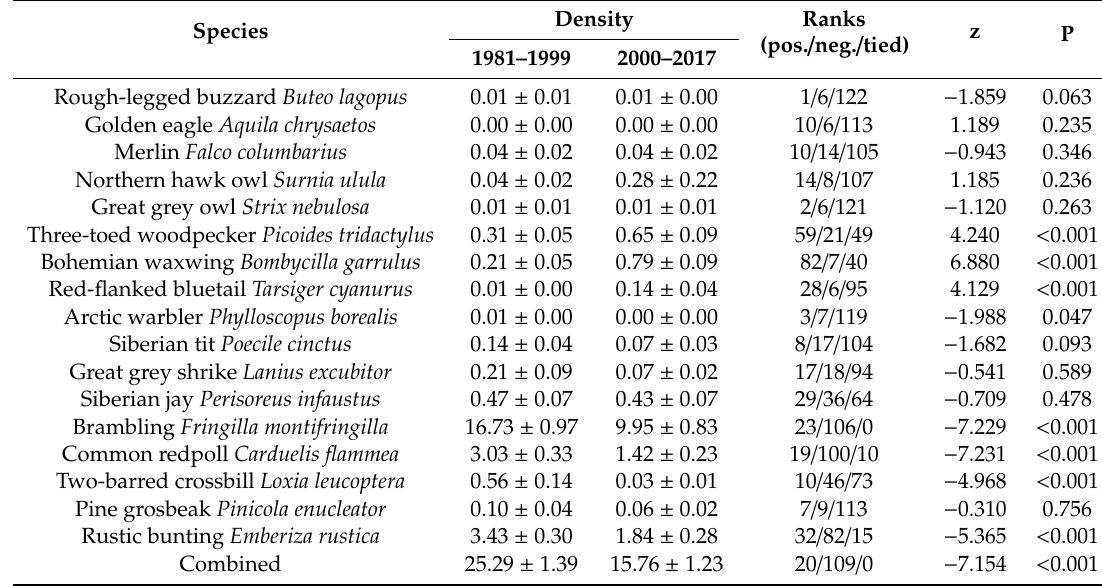
Table 1. Mean density (pairs / km 2 ± standard error) of northern forest bird species in 1981–1999 and in 2000–2017 in the 129 protected areas. The statistical significance between the time-periods is based on a paired Wilcoxon signed rank test with positive, negative and tied ranks from 1981–1999 to 2000–2017. Density values of 0.00 denotes density of less than 0.005 pairs / km 2 . Density Ranks Species (pos. / neg. /